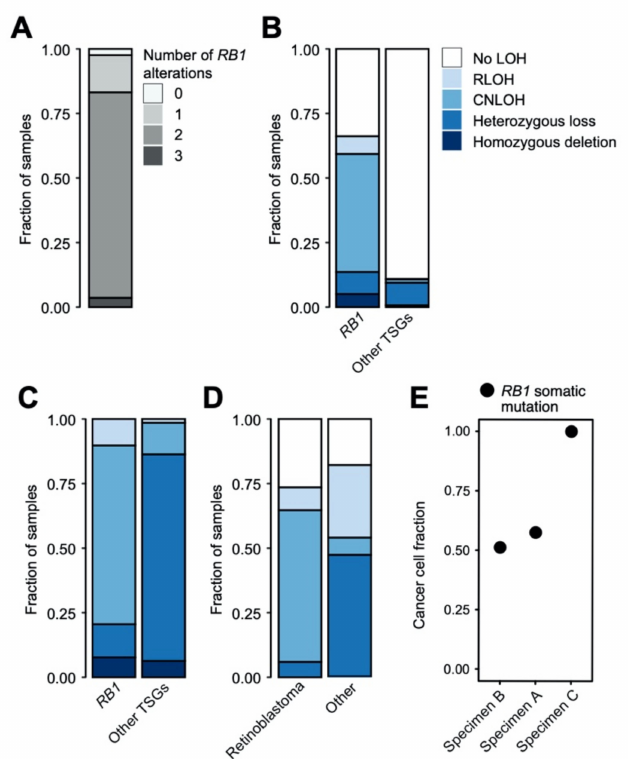
Figure 2. Mechanisms of inactivation of RB1. ( A ) Stacked bar graph depicting number of hits to RB1 in 83 eyes. ( B , C ) Bar plot showing the types of loss of heterozygosity that occurs in retinoblastoma samples at the RB1 locus vs. loci of other tumor suppressor genes as annotated by OncoKb [23,24]. ( C ) Bar plot of the proportion of each type of loss of heterozygosity across the specimens, excluding those without any type of loss. There is a significantly higher proportion of CN-LOH at the RB1 locus ( p < 2.2 × 10 − 16 , OR = 19.8). ( D ) Bar plots comparing the types of loss of heterozygosity at the RB1 locus in malignancies with RB1 mutations. Retinoblastoma samples are compared to all other types of malignancies. There is significantly higher proportion of CN-LOH at the RB1 locus in retinoblastoma compared to other malignancies ( p < 2.2 × 10 − 16 , OR = 44.4). ( E ) For the somatic variants in the specimens with three detectable hits to RB1, we calculated the variant allele frequency corrected for purity of the sample and ploidy of the region (cancer cell fraction). Each column is the variant from a different specimen. Specimens are labeled based on Figure